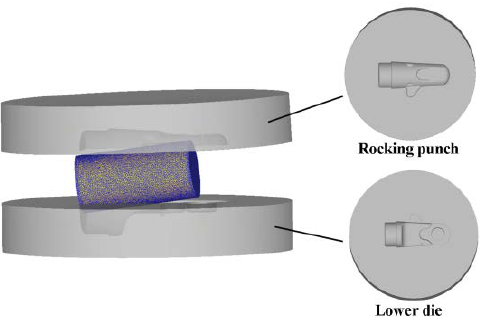
Figure 5. 3D FE models for cold orbital forming of aluminum alloy component with complex shape. Table 1. The simulation parameters for one-step cold orbital forming base.